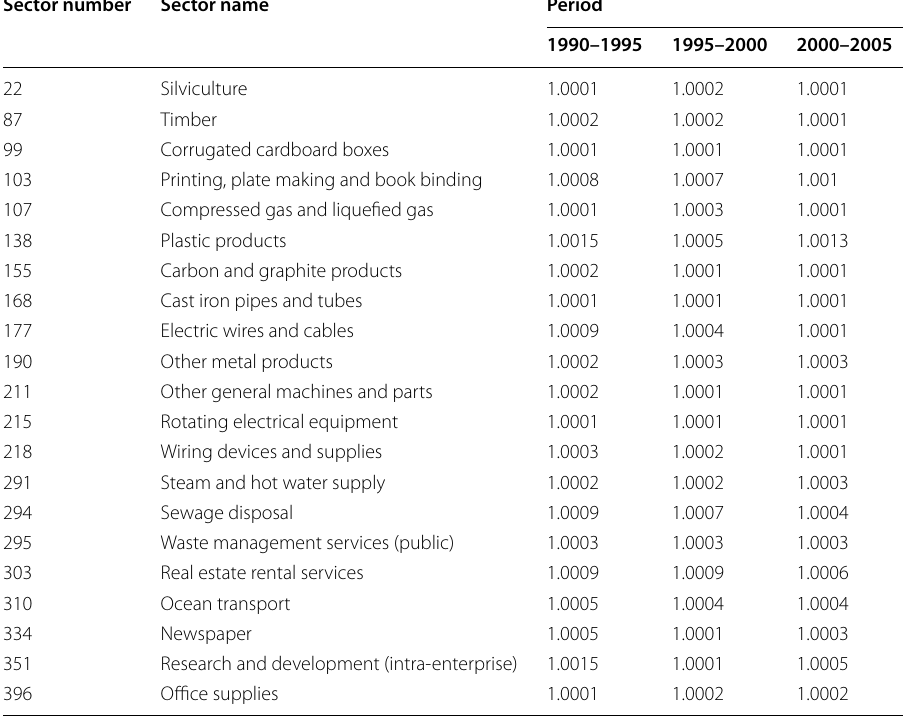
Table 1 Sectors whose forward linkage increased GHG emissions in Japan in all study periods (1990–1995, 1995–2000 and